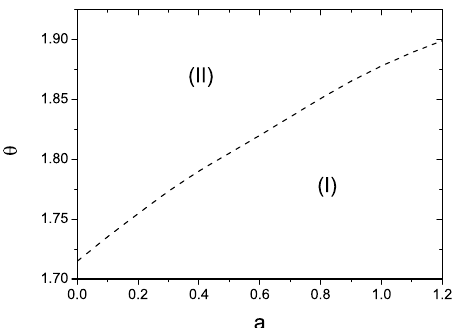
Figure 3. Phase diagram for the bulk ordering transition, described by the non-dimensional chemical potential and temperature. The nematic and isotropic phases correspond to regions I and II , respectively. The dashed line represents the discontinuous phase transition.